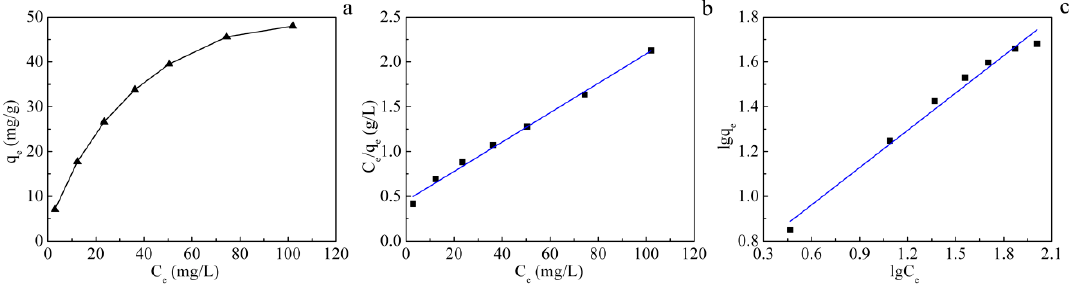
Table 2. Langmuir and Freundlich parameters for Pb(II) adsorption at 25 °C. Langmuir Parameters